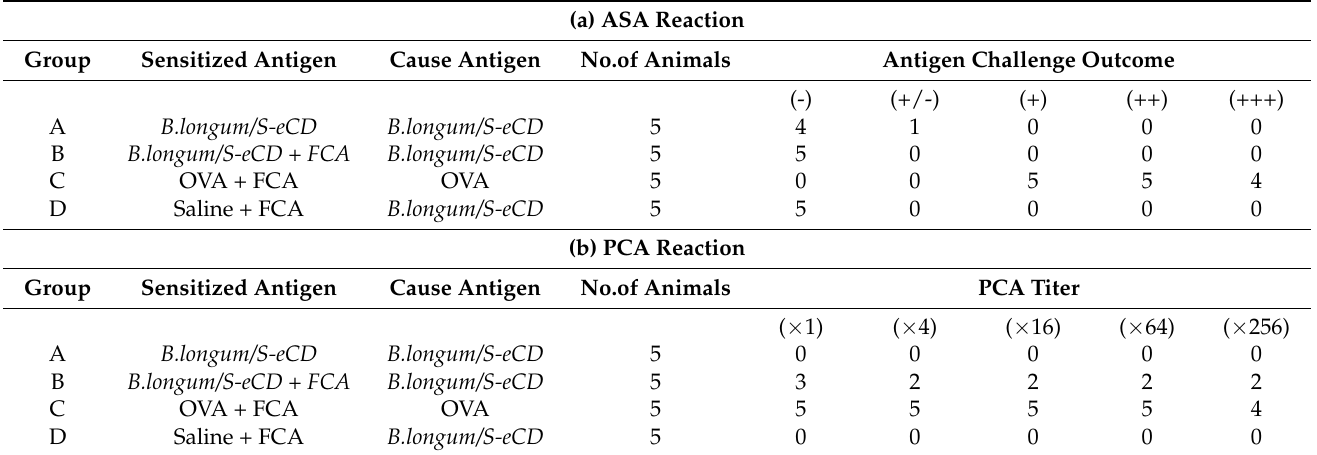
Table 1. Antigenic tests to estimate the toxicity of B. longum /S-eCD.